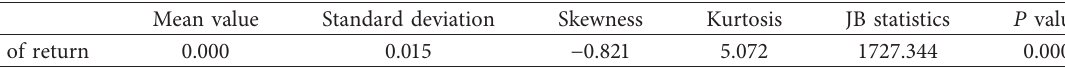
Table 2: Descriptive statistical analysis table.